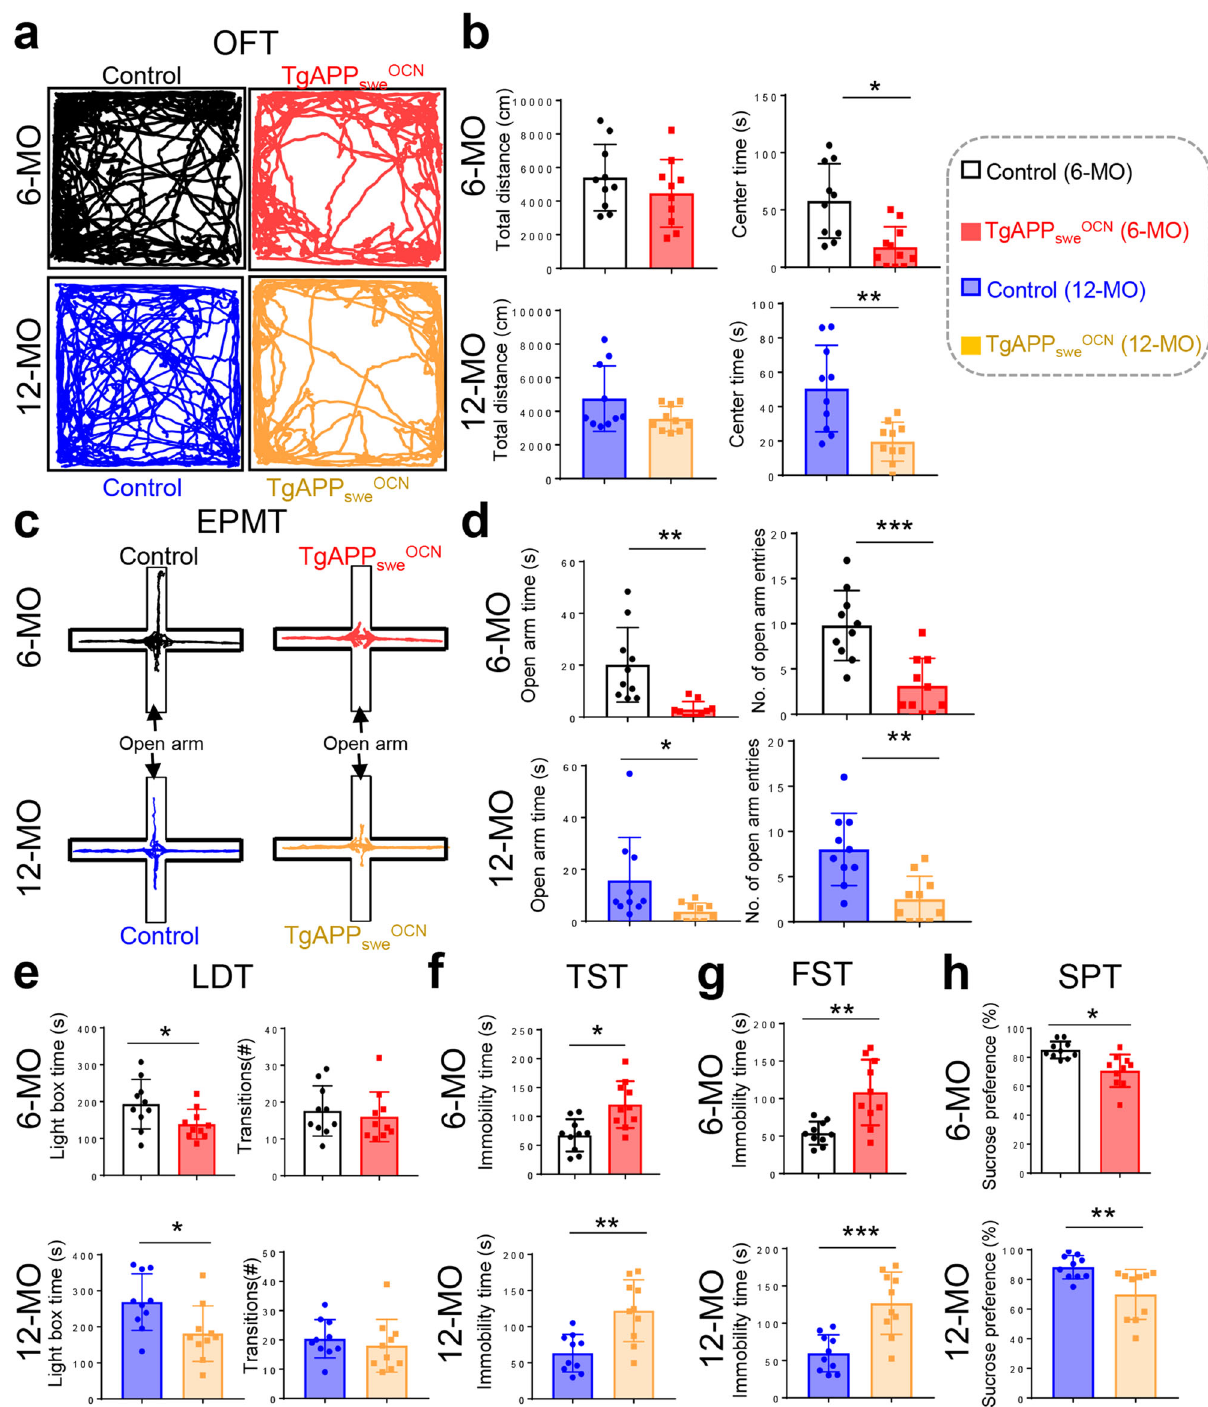
Fig. 3 Age-dependent anxiety- and depression-like behaviors in TgAPP swe OCN mice. a , b OFT: Representative tracing images ( a ), and quanti fi cations of total distance and center duration time ( b ) were shown. c , d EPMT: Representative tracing images ( c ), and quanti fi cations of open arm duration time and entries ( d ) were shown . e LDT: Quanti fi cations of the time spent in the light room and the number of transitions into the light room. f TST, g FST, and h SPT. In all these behavior tests, 6-MO and 12-MO control ( LSL-APP swe ) and TgAPP swe OCN mice (males) were examined. All quanti fi cation data were shown as mean ± SD ( n = 10 mice). * p < 0.05, ** p < 0.01, *** p < 0.001, Student ’ s t